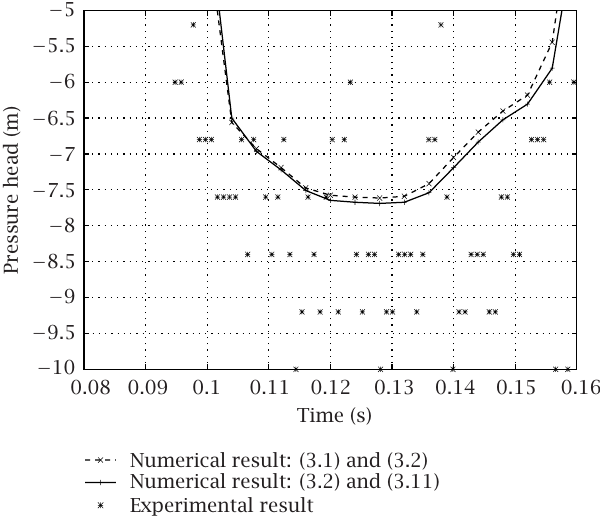
= 0 . 122m/s, 0 . 08 ≤ t ≤ 0 . 0